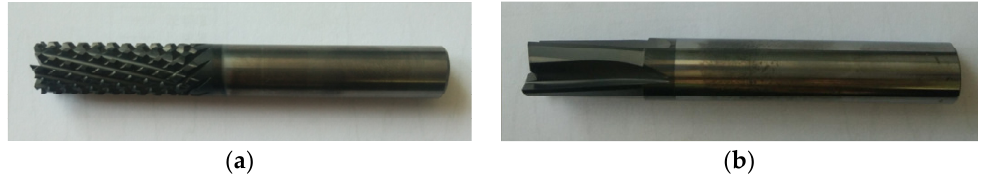
Figure 2. Two styles of milling cutter, ( a ) the rhombic milling cutter and ( b ) the staggered helical milling cutter.